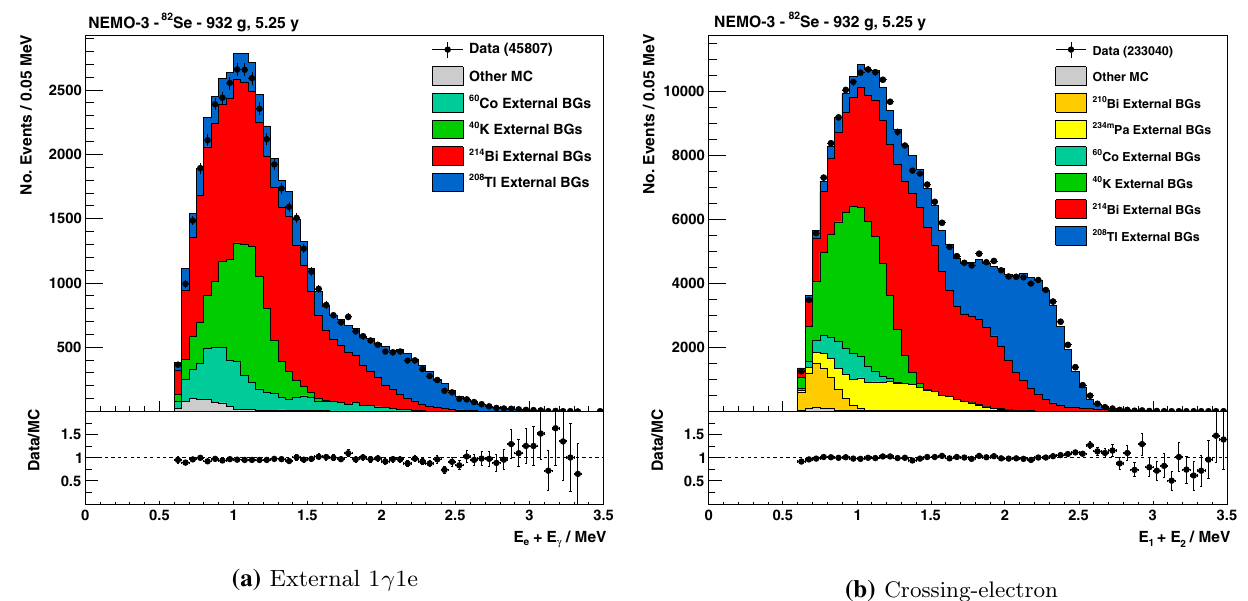
Fig. 2 a Distribution of the sum of the energies of the electron and γ -ray in the external 1 γ 1e channel. b Distribution of the sum of the incoming and outgoing electron energies in the crossing-electron chan- nel. In both figures, the energy spectra from data are compared to the